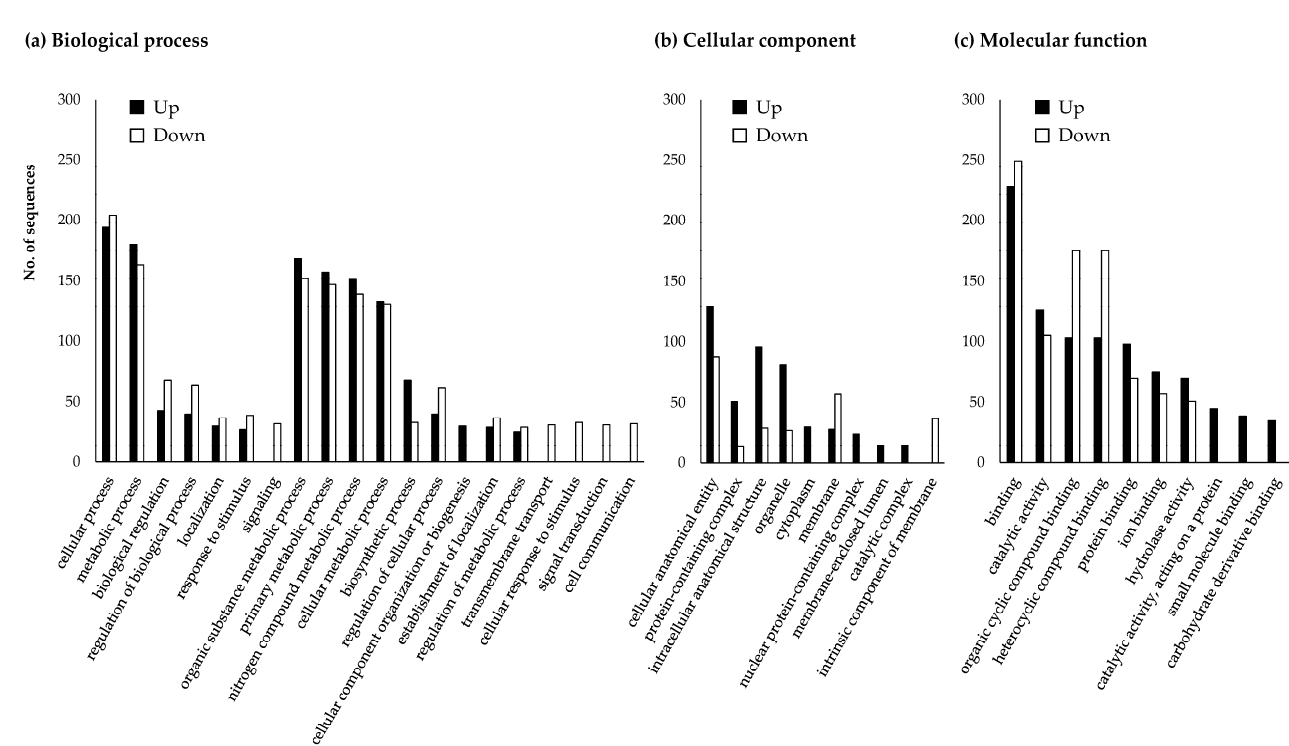
Figure 3. Gene ontology (GO) analysis of DEGs of JPS beetles treated with M. anisopliae JEF-197. Unigenes over 2-fold upregulated and less than 0.5-fold downregulated were subjected to analysis using InterProScan. DEGs were identified as being involved in the three GO categories: ( a ) biological process, ( b ) cellular component, and ( c ) molecular function.